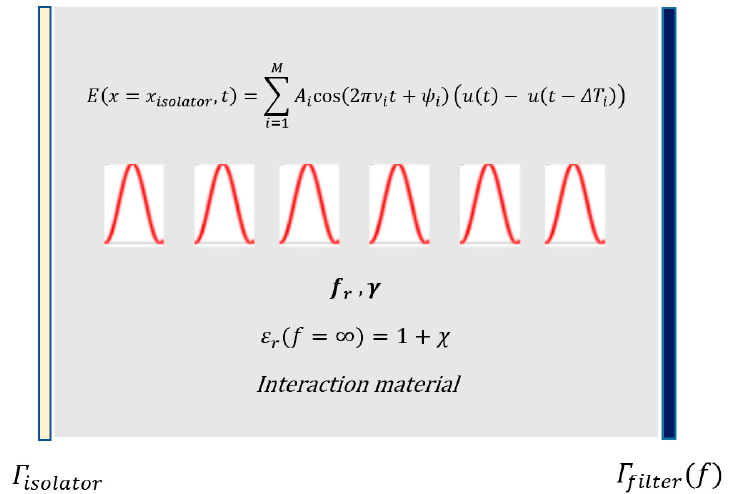
Figure 1. Excitation of an optical microcavity using M different ultrashort pulses, whose frequencies are to be tuned for high-intensity targeted harmonic generation via intracavity energy maximization. Equations (1)–(4) can be discretized using the FDTD method at each iteration ( k ) of the optimization as follows: